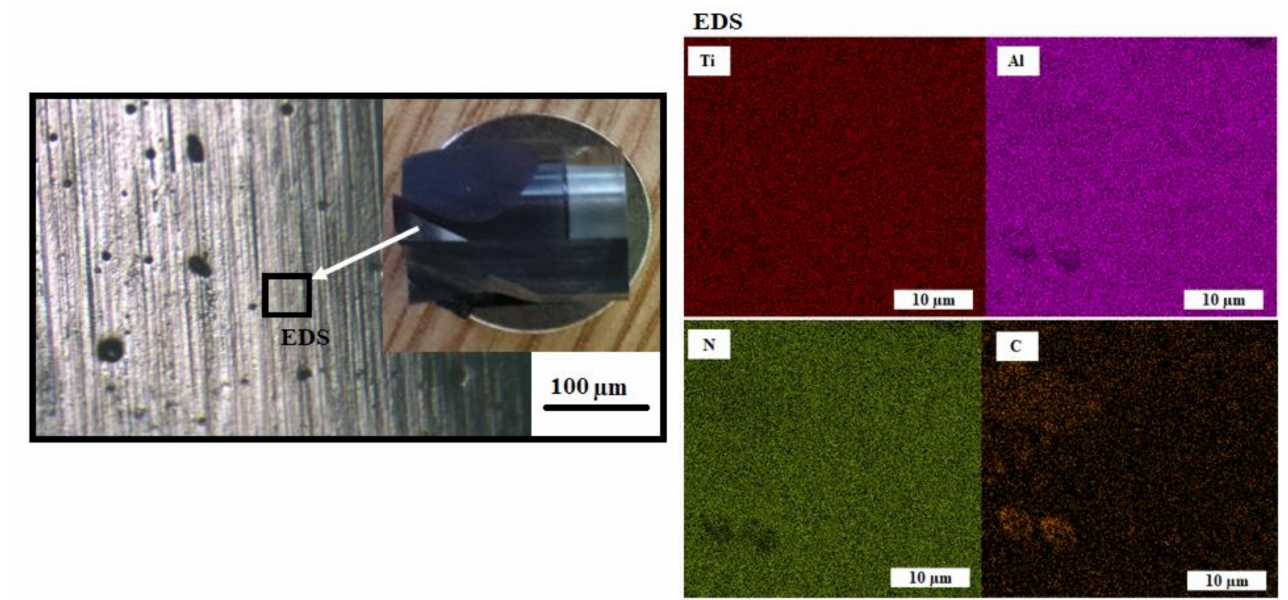
Figure 8. EDS analysis of the layout of individual elements in the TiAlN